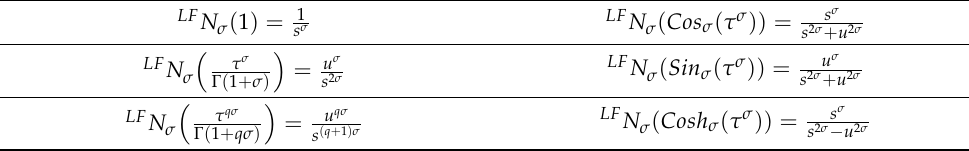
Table 1. LFNT of some